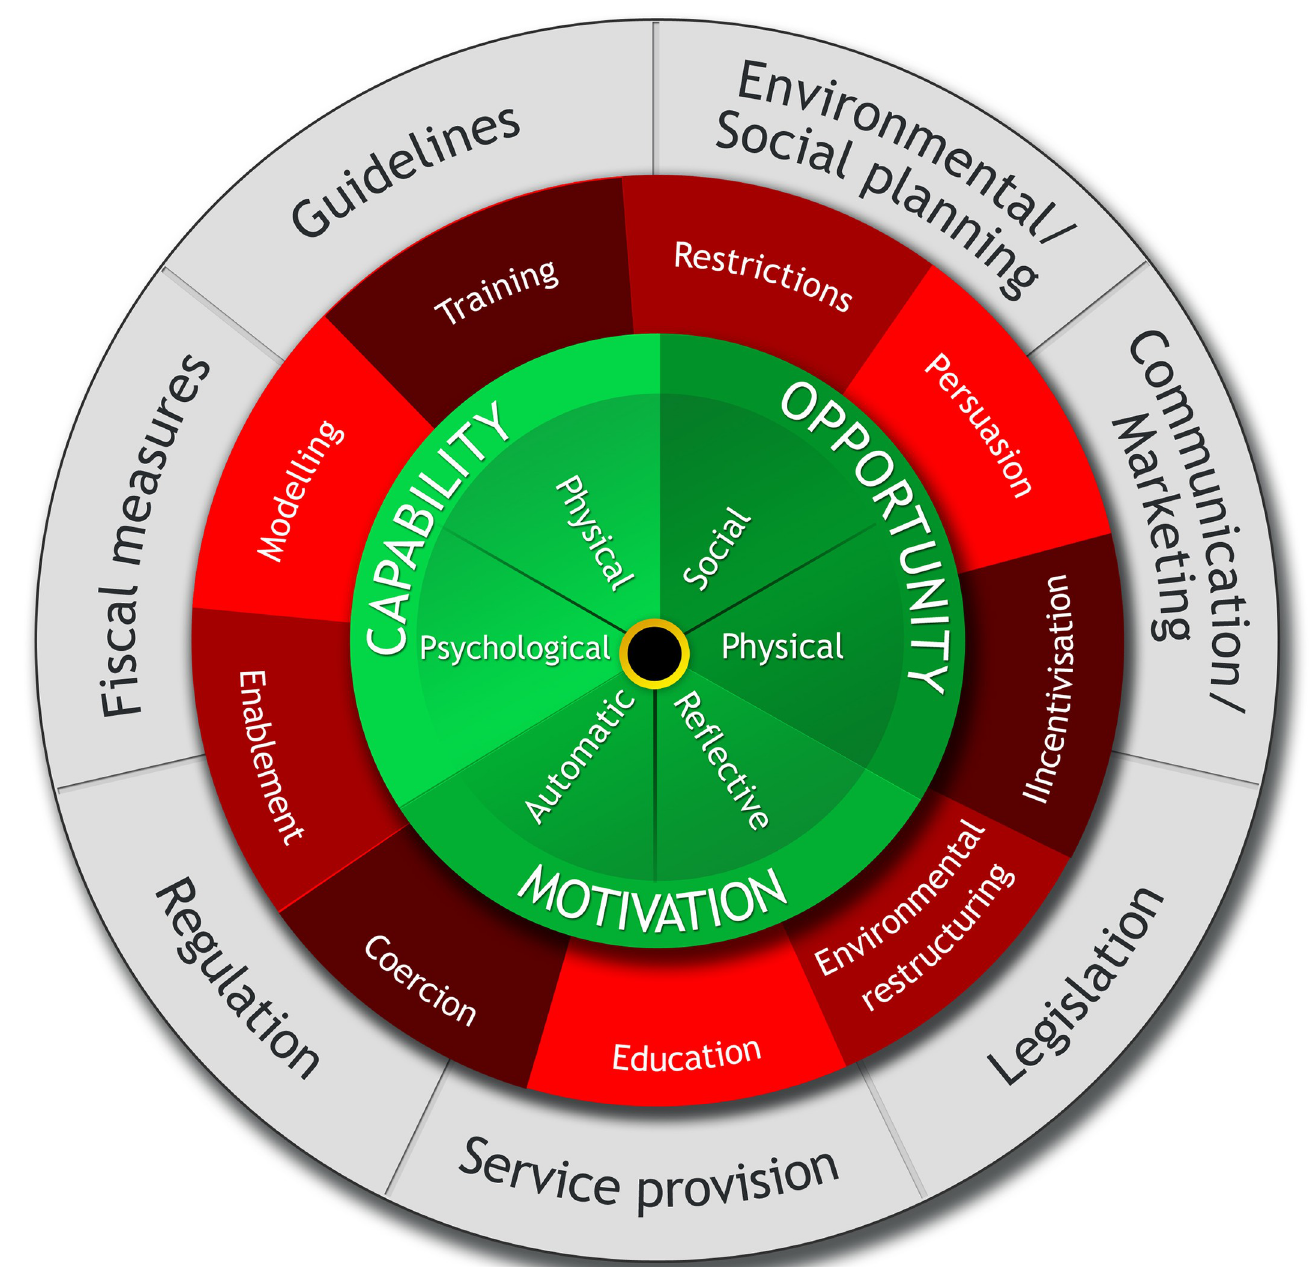
Fig 1. Behaviour change wheel. Reproduced with permission